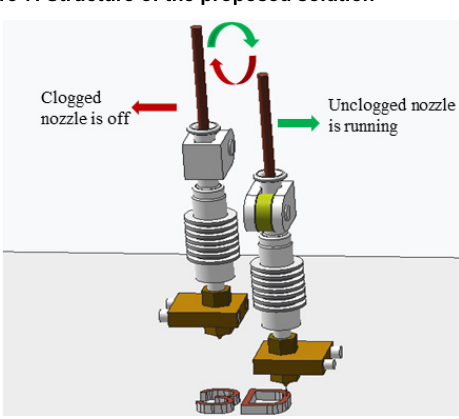
Figure 8. Structure of the proposed solution